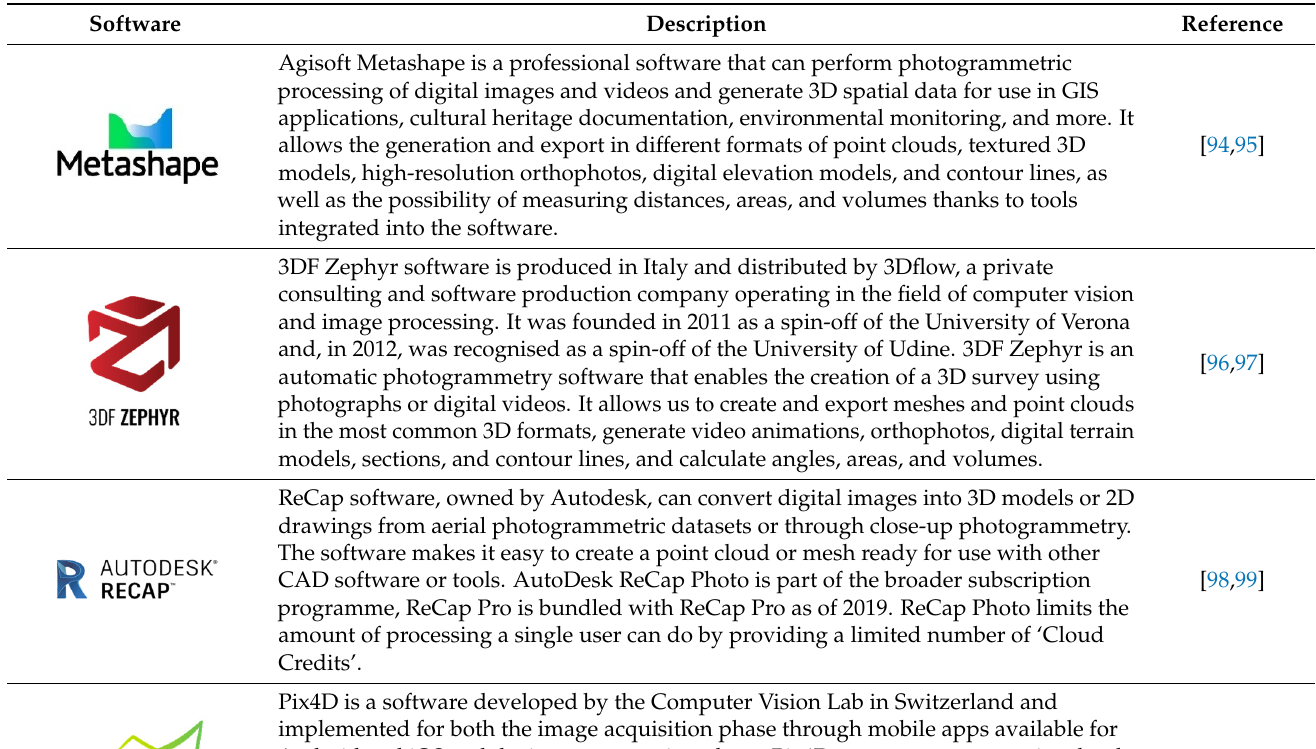
Table 7. Main commercial photogrammetric software.